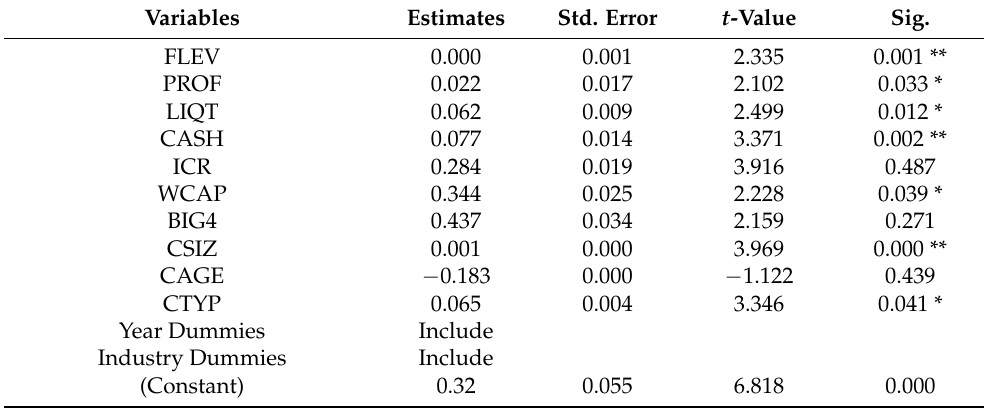
Table 8. Robustness analysis